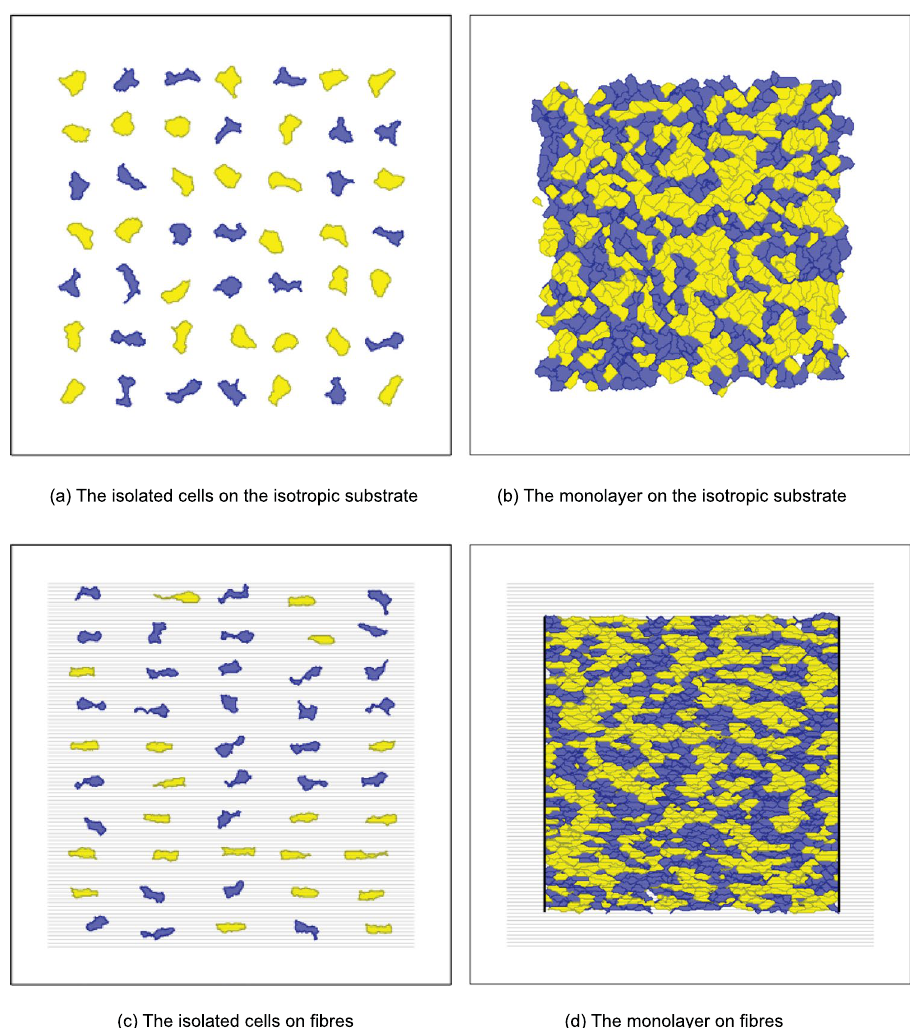
Figure 4. Examples of simulations for four seeding conditions. Cardiomyocytes are shown in yellow tints, whereas fibroblasts are shown in blue tints. Here the proportions of the cells of each type were 50%. Black lines in ( d ) show the borders that constrain the anisotropic monolayer. In ( c ) and ( d ), grey horizontal lines show